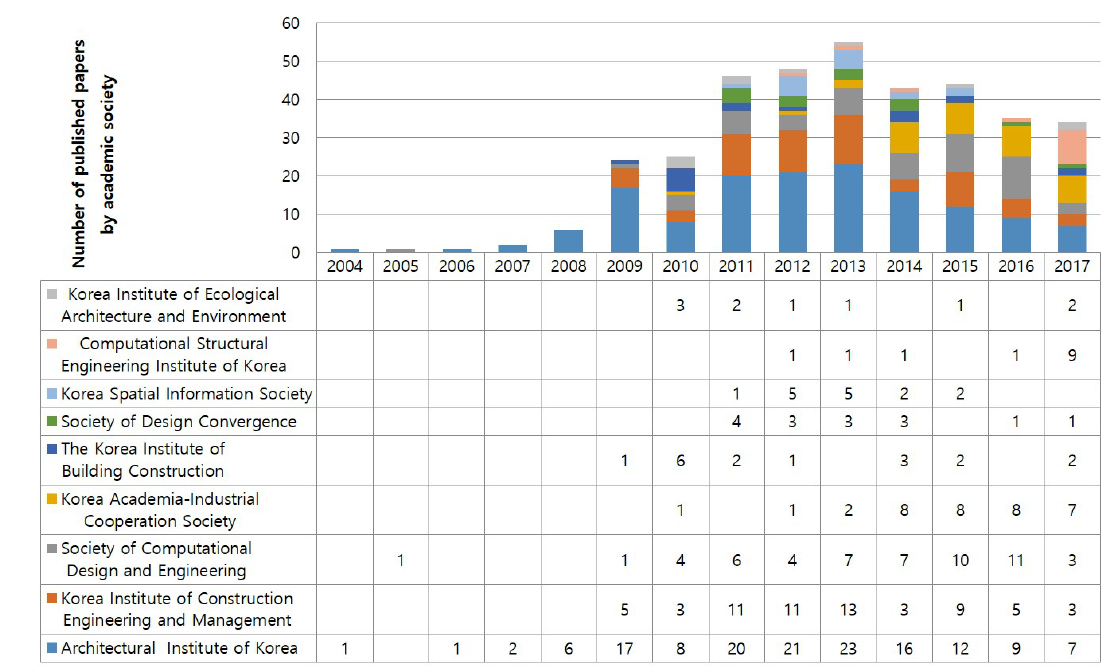
Figure 3. Number of papers published by academic societies